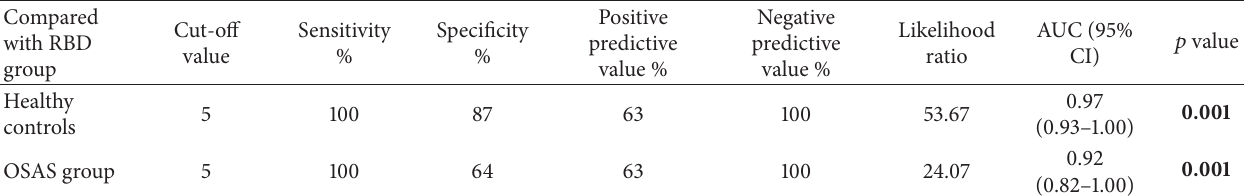
Figure 1: (a) Graph shows the receiver operating characteristic (ROC) curve for the rapid eye movement sleep behavior disorder (RBD) group versus the healthy control group. Area under the curve (AUC) = 0.974 (95% CI: 0.936–1.00; 𝑝 = 0.001 ). (b) Graph shows the ROC for the RBD group versus the obstructive sleep apnea syndrome (OSAS) group. AUC = 0.921 (95% CI: 0.826–1.00; 𝑝 = 0.001 ). Table 2: Stratified analysis of the rapid eye movement sleep behavior disorders screening questionnaire-Turkish version (RBDSQ-T) results between